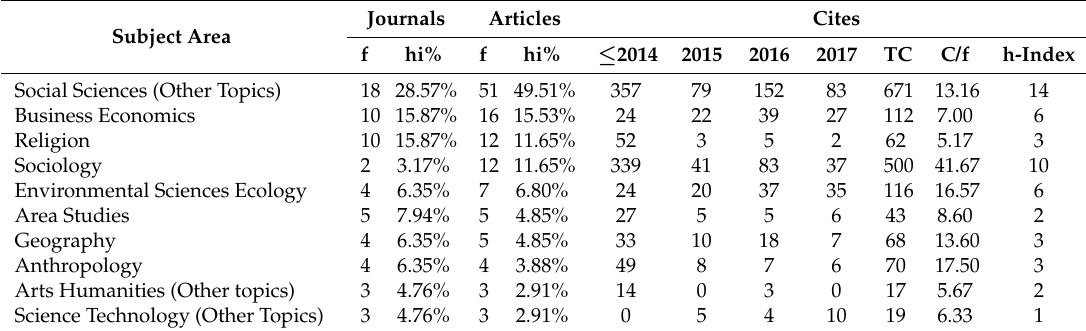
Table 8. Main Thematic Areas where articles on Religious Tourism are collected.